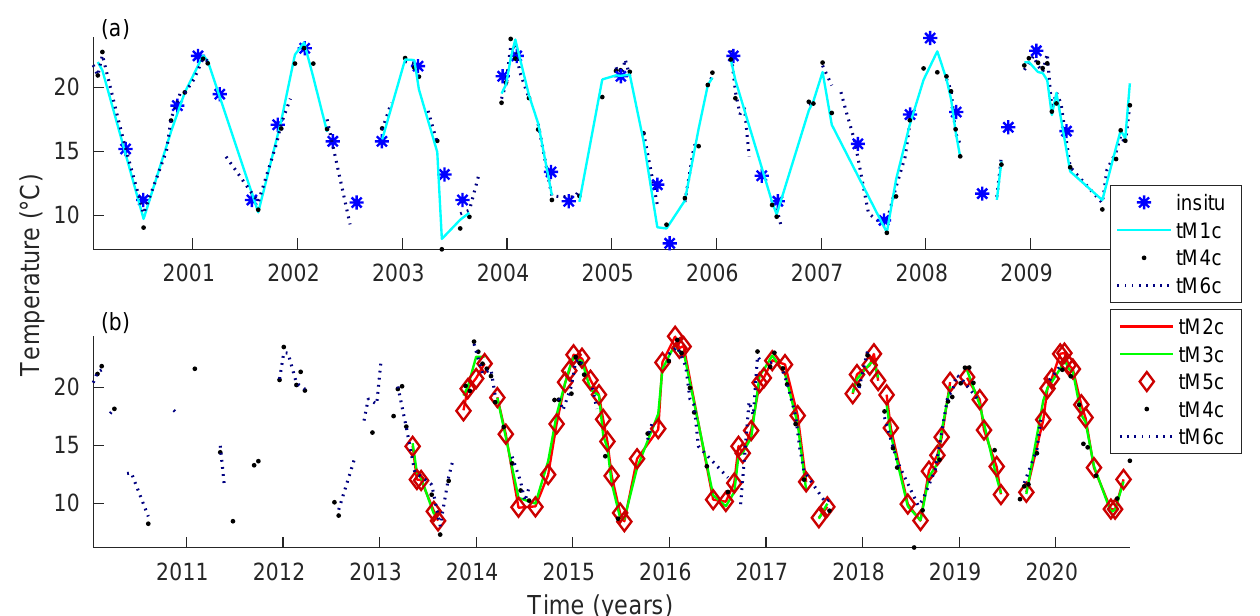
Figure 4. Calibrated time series of LSWT (tM1c, tM2c, tM3c, tM4c, tM5c and tM6) and in situ series in Laguna Grande in Centro (C) station for the period ( a ) 2000–2010 and ( b ) 2010–2020. The dates of the images used from landsat 7 and 8 can be seen in black dots and red rhombuses, respectively. In situ data are in blue